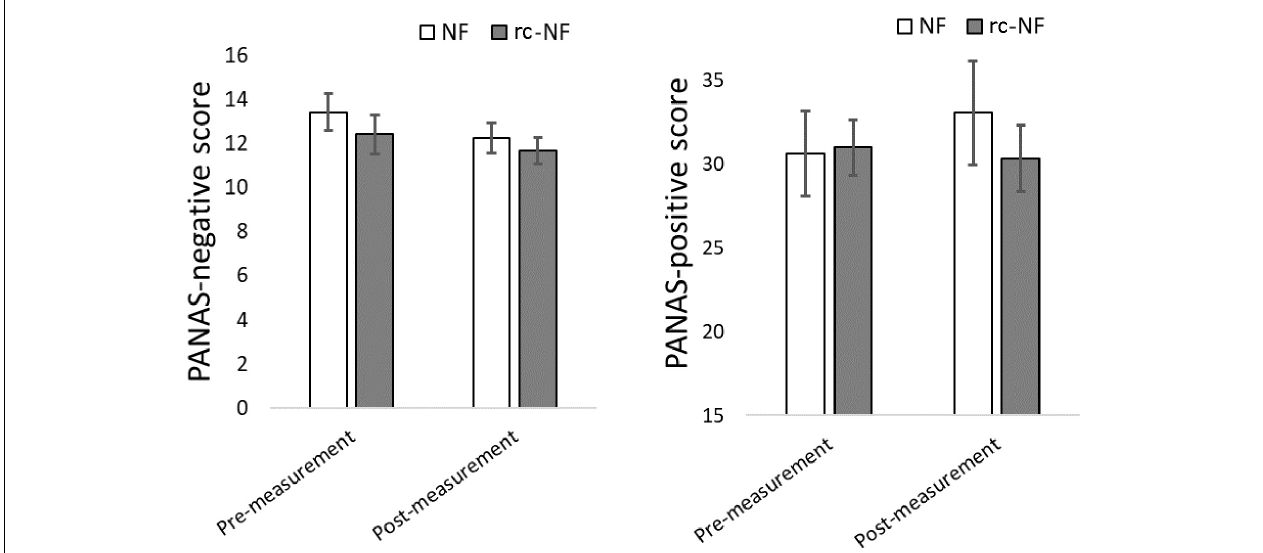
FIGURE 8 | (Left) PANAS negative affect decreased on a trend level for both groups after the NF-training. (Right) A trend to a less negative and a more positive affect change in the NF group emerged, but the comparisons failed significance.